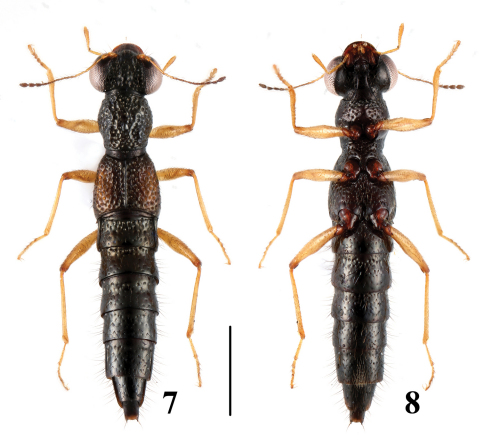
 Habitus ofStenus maoershanus in dorsal and ventral view. Scale = 1 mm.